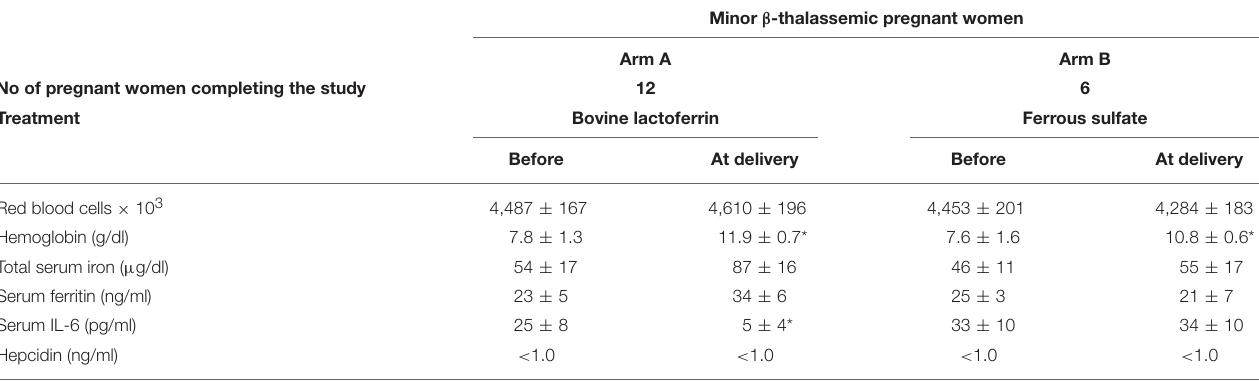
TABLE 5 | Hematological parameters, serum IL-6 and hepcidin mean values ± SD of anemic minor β -thalassemic pregnant women treated with bovine lactoferrin (Arm A) or ferrous sulfate (Arm B), before the treatment and at